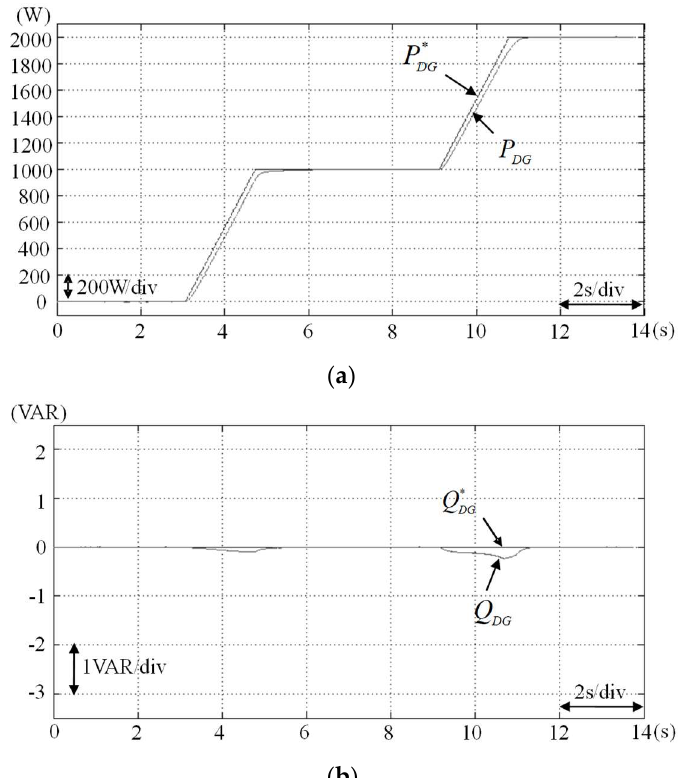
Figure 6. Experimental result of DG using PI controllers for active and reactive power control: ( a ) Response of active power; ( b ) Response of reactive power.